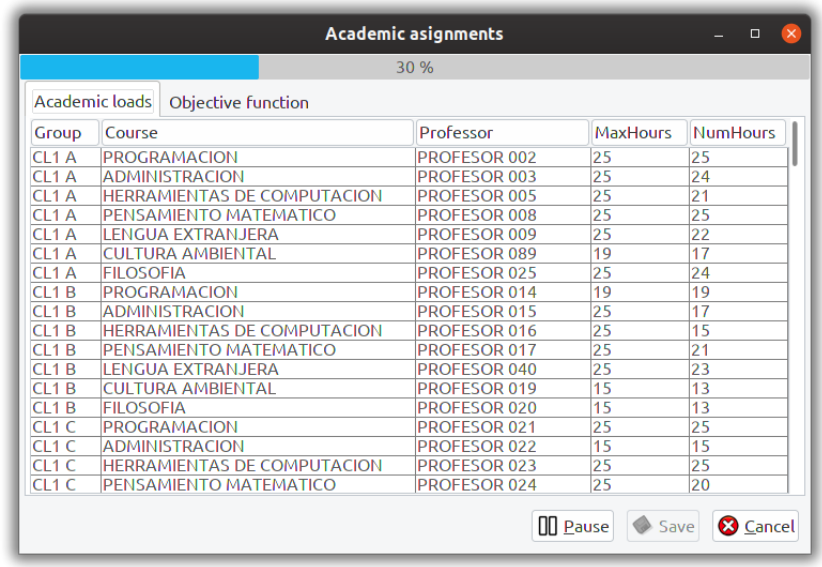
Figure 12. Academic assignments: list of professors with assigned